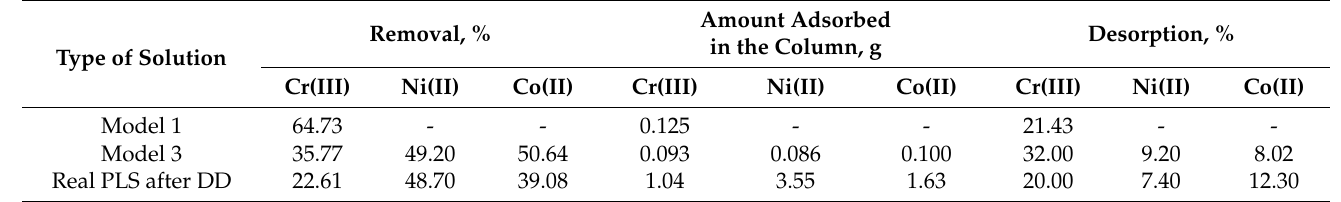
Table 8. Adsorption of Cr(III), Ni(II) and Co(II) from the model and real solutions after 24 h and percentage desorption in one cycle with 100 cm 3 1.5 M H 2 SO 4